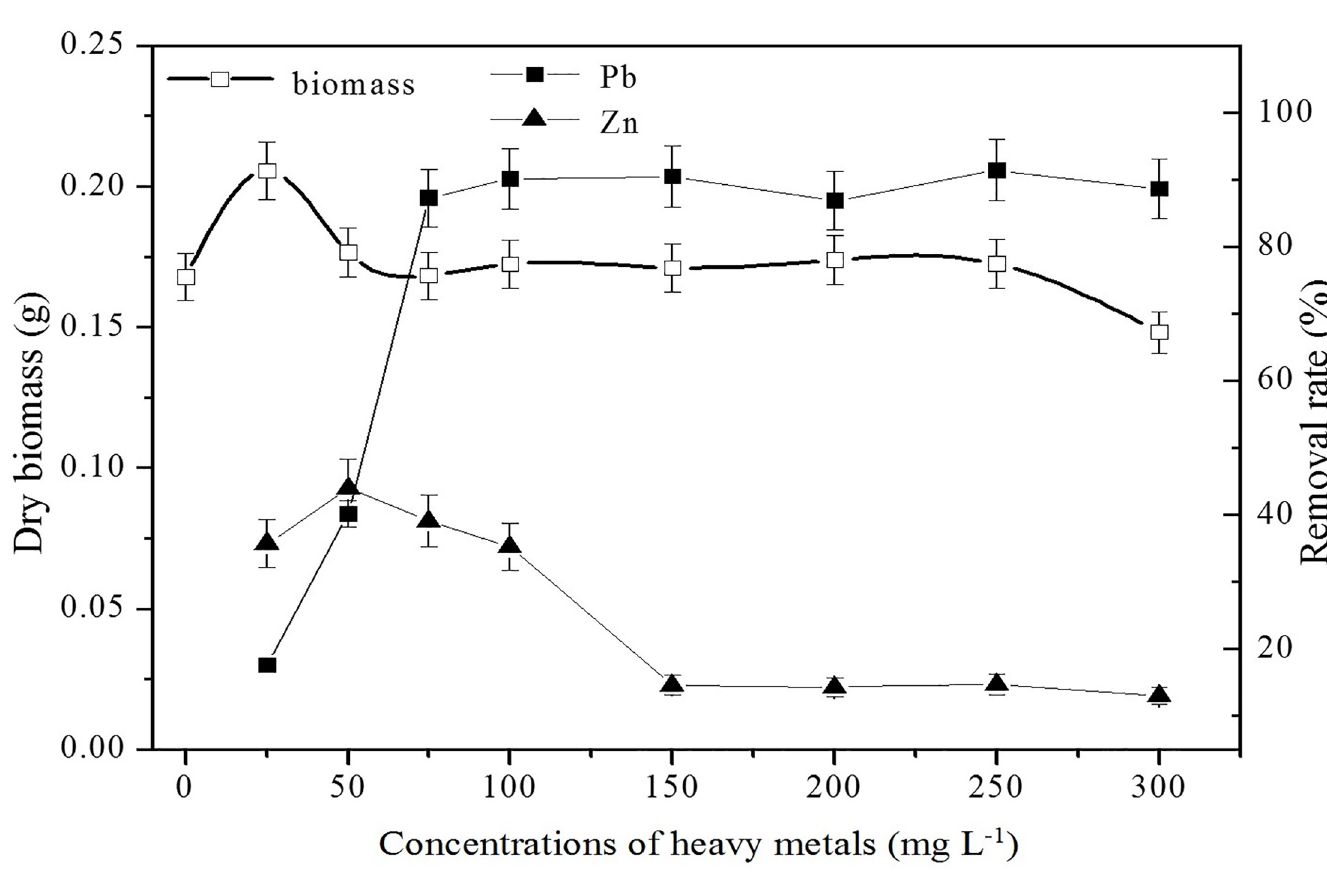
Fig 2. The effects of the initial concentrations of Pb(II) and Zn(II) on biosorption. Biosorption conditions: initial pH = 4, absorption time 7 days, initial biomass does 2 mL L -1 , temperature 30˚C. (Error bar represents means ± SE, P < 0.05, and n =